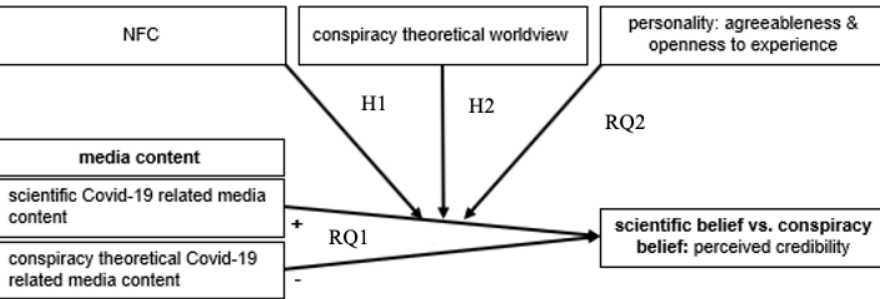
Figure 1. Structure of hypotheses and research questions.